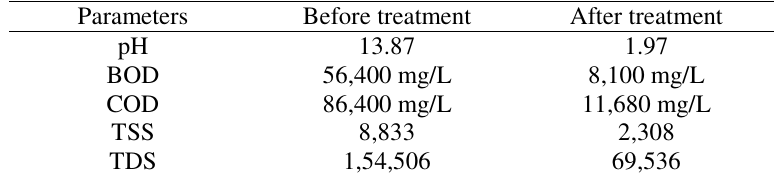
Table 1. Characterization of black liquor before and after